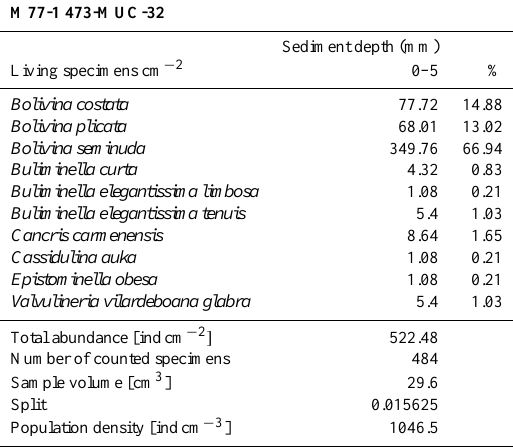
Table A2. Sampling sites for pore water nitrate